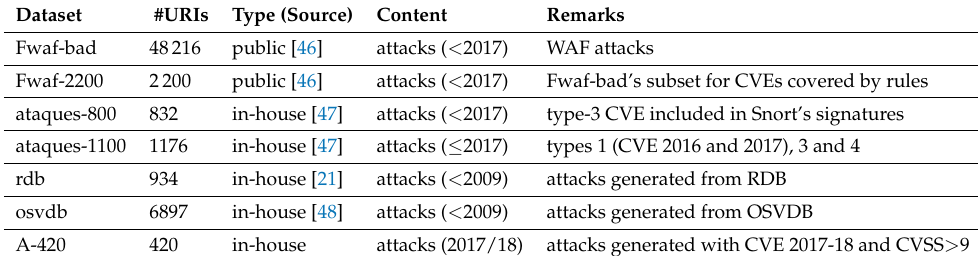
Table 2. Attack datasets